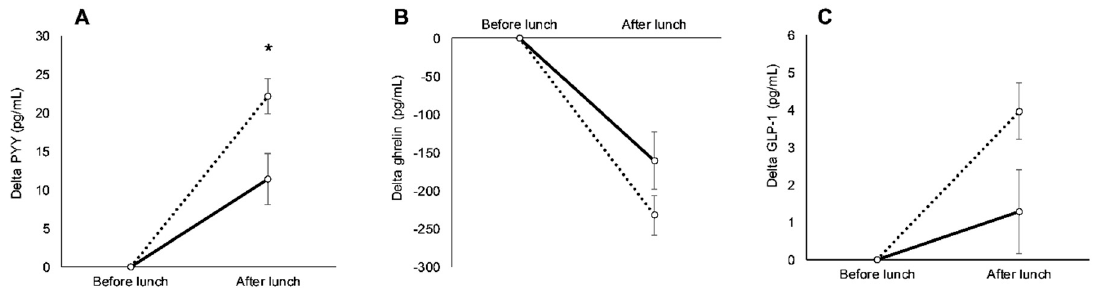
Figure 2. Differences in delta peptide YY (PYY) from before lunch ( A ), delta ghrelin from before lunch ( B ), and delta glucagon-like peptide-1 (GLP-1) from before lunch ( C ) between African Americans (AAs; solid line) and Whites (dashed line) during the baseline visit. * Significant difference between races (mean p < 0.05). Values are means ± SEM.